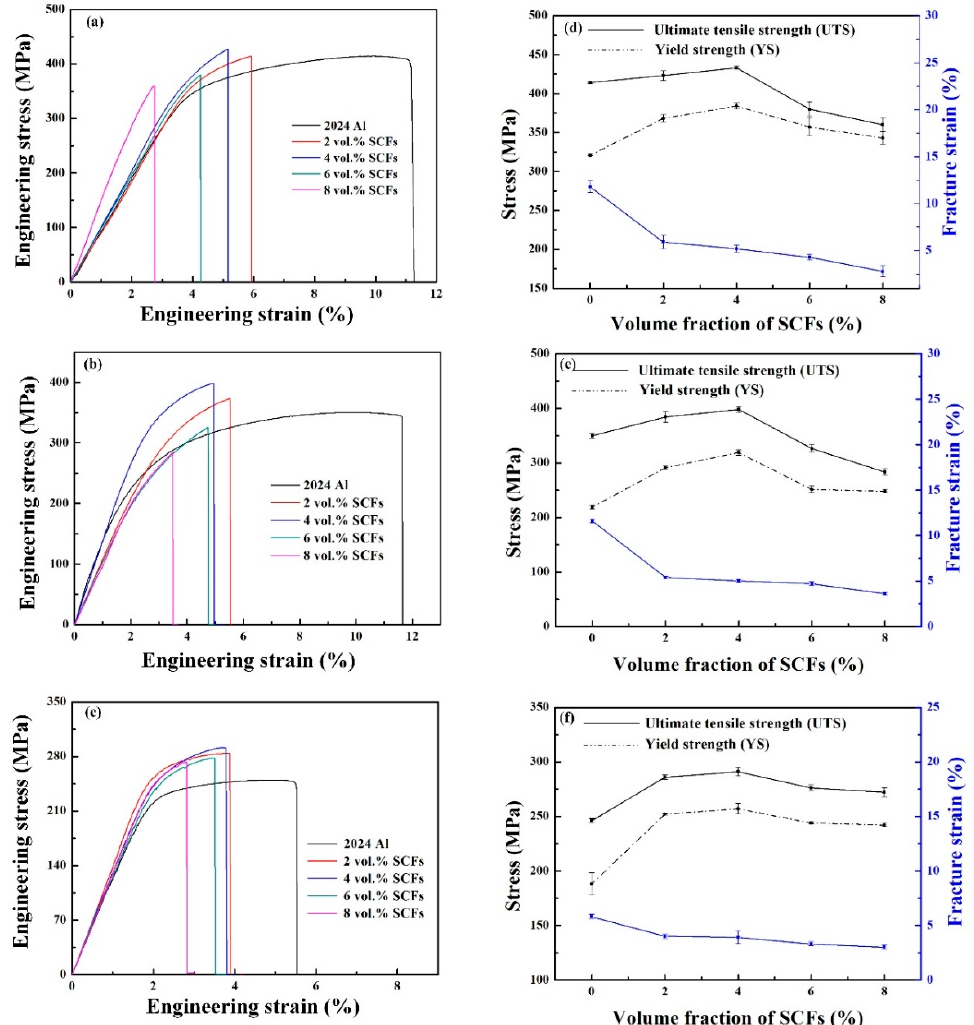
Figure 9. Engineering stress-strain curves and evolution curves for the tensile properties of 2024 Al and SCFs / 2024 Al composites at ( a ) and ( d ) room temperature, ( b ) and ( e ) 423 K and ( c ) and ( f ) 523